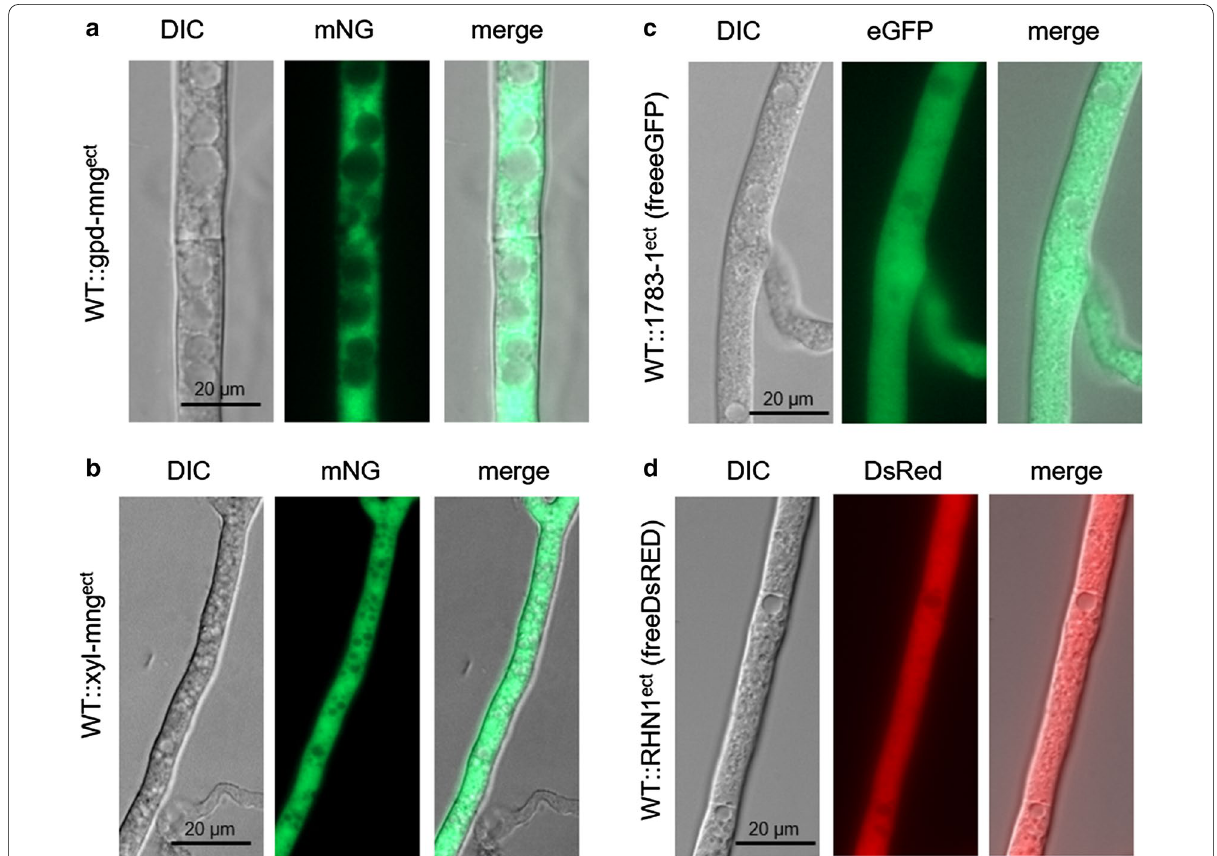
Fig. 4 Fluorescence microscopy of cytosolic-targeted mNG, eGFP and DsRed in S. macrospora . a mng expression under control of the constitutive gpd promoter of A. nidulans , b mng expression under control of the induced Smxyl promoter, c expression of egfp under control of the gpd promoter, d expression of DsRed under the control of the gpd promoter. The exposure time for image acquisition of all strains was set to be the same. Scale bar, 20